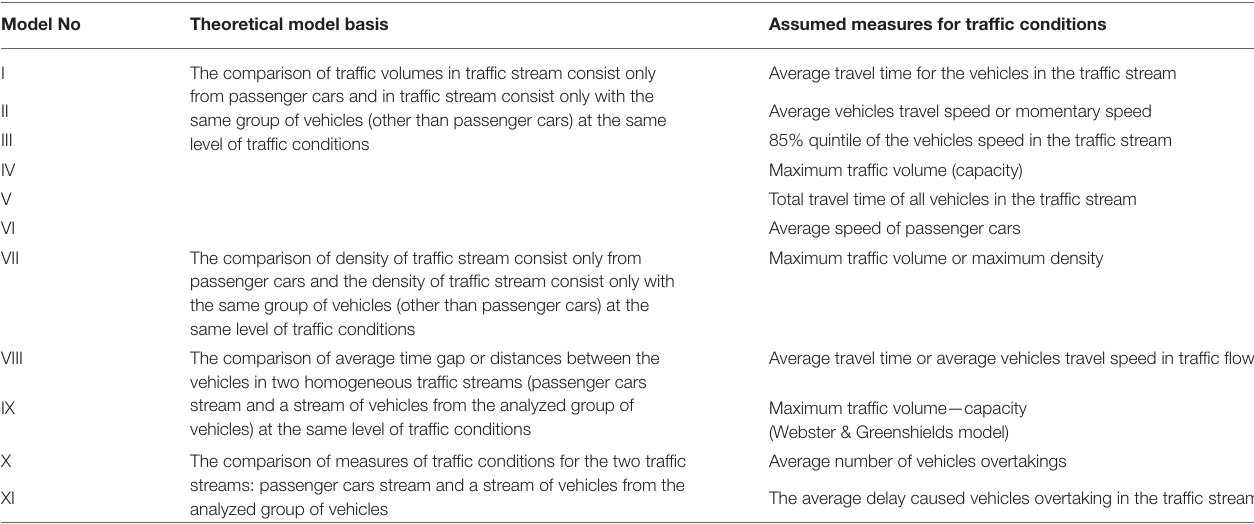
TABLE 2 | Theoretical models used for passenger car equivalent factors calculation.